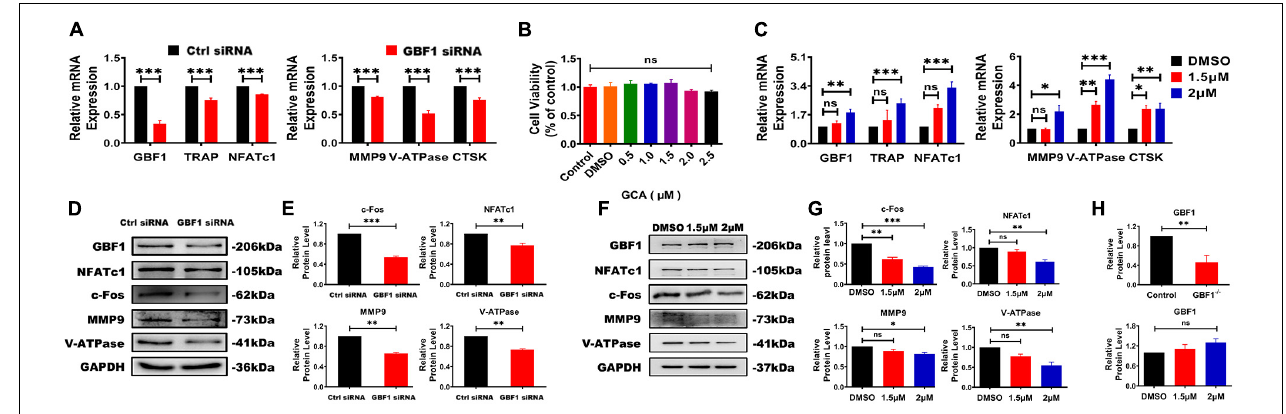
FIGURE 2 | Inhibition of GBF1 reduced the expression of osteoclast-specific gene and protein. (A,B,H) The mRNA and protein levels of GBF1, c-Fos, NFATc1, TRAP, NFATc1, MMP9, V-ATPase, and CtsK were analyzed by quantitative real-time PCR and western blot, respectively. The intensity of the blots was quantified using densitometry scan and Image J software. E11 transfection was compared with NC for statistical analysis. (B) The effect of GCA (concentration range from 0.5 µ M to 2 µ M) on RAW264.7 cells viability was measured using the CCK8 assay for 3 days. (C,F–H) Cultured RAW264.7 cells in the presence of RANKL (50 ng/ml) were treated with 1.5 and 2 µ M GCA for 3 days, and the DMSO group served as the control group. Quantitative real-time PCR and Western blot were used to detect the changes of the aforementioned genes. Data are expressed as mean ± SD of three independent experiments. ∗ p < 0.05; ∗∗ p < 0.01; ∗∗∗ p < 0.001.